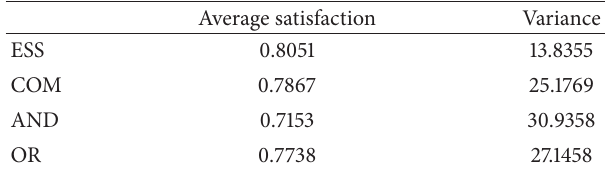
Table 5: Comparison of different ranking methods